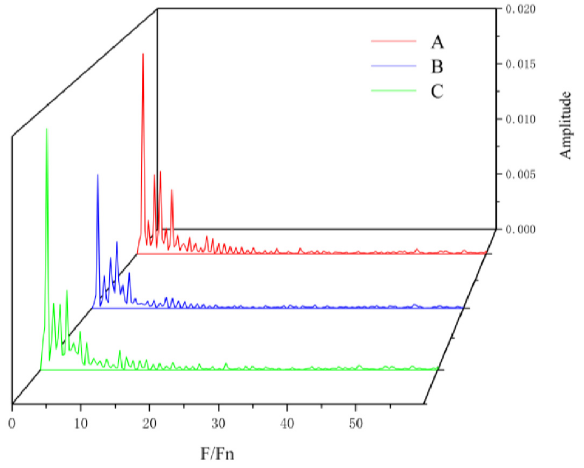
Figure 15. Pressure frequency of P5 (volute tongue) in the volute. Figure 16 exhibits the pressure distribution of the three points in the rotor